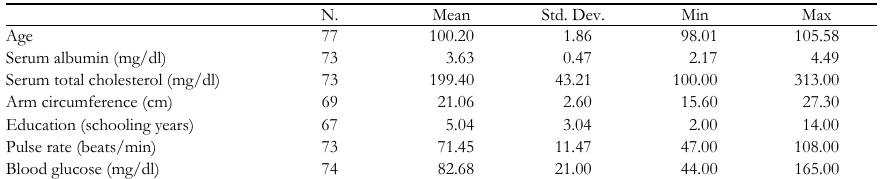
Descriptive statistics for quantitative